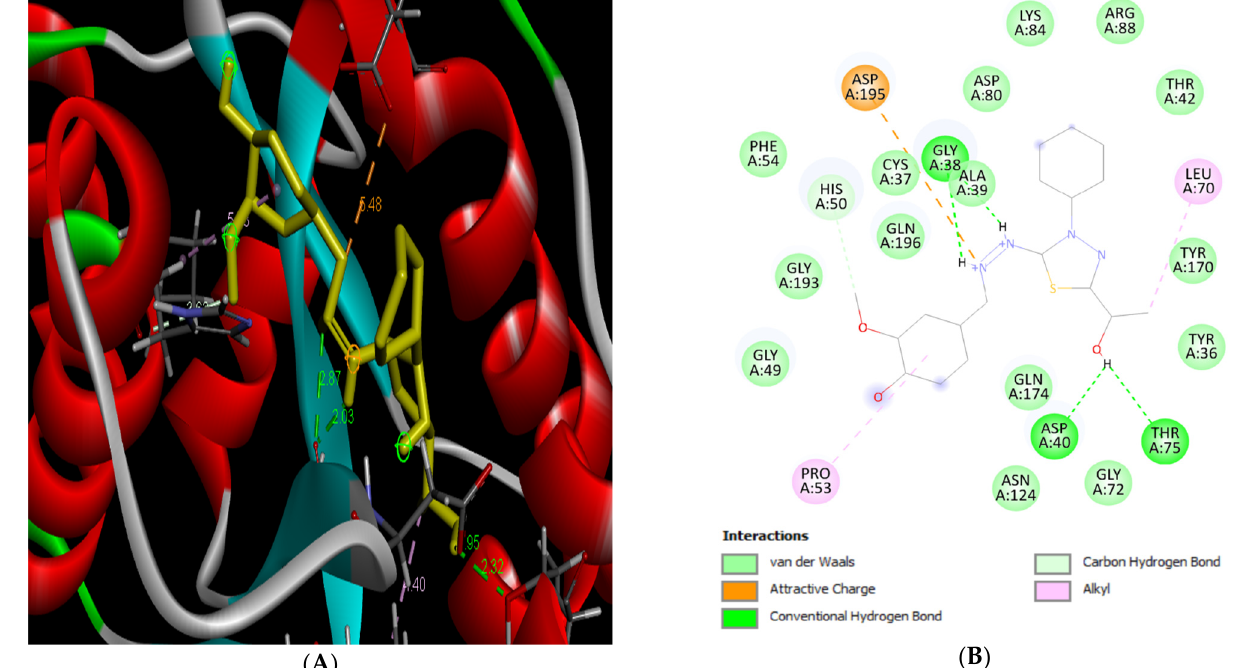
Figure 5. 2D ( B ) and 3D ( A ) representation of compound 6 docking with TyrRS.